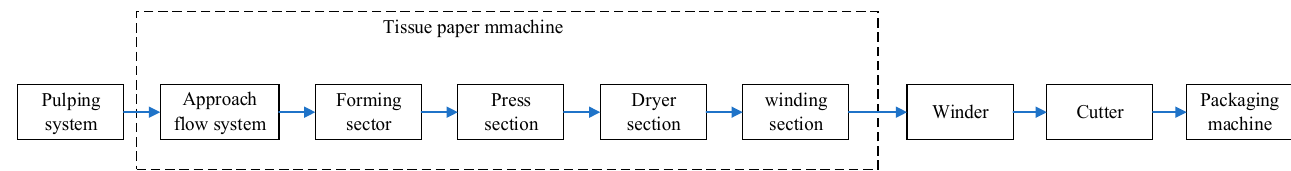
Figure 1. The production process of tissue paper mills.